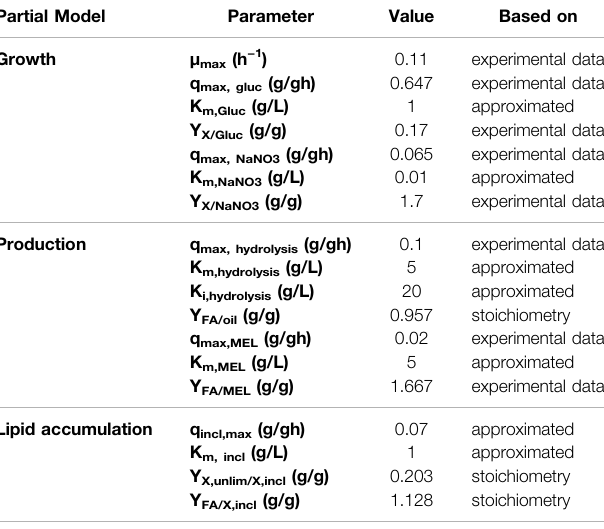
TABLE 4 | Overview of parameters used for kinetic modeling. Parameters were either calculated from experimental data, derived from reaction stoichiometry or approximated to fi t the model to experimental